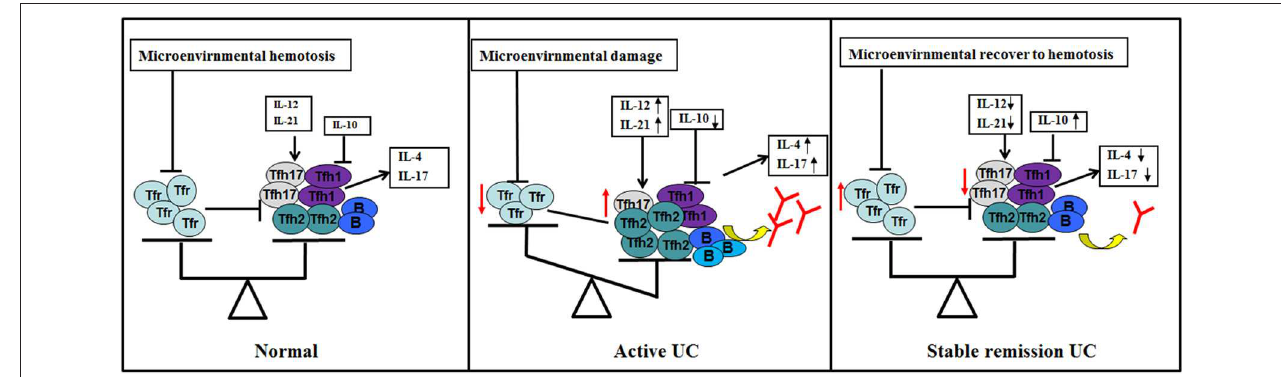
FIGURE 8 | Hypothetical schematic of the study. TFR and TFH and subgroups (TFH1/TFH2/TFH17) in normal human body (GALT and peripheral blood) are in equilibrium (left). When UC occurs and the disease is active (middle), (1) changes in microenvironment caused by certain factors, such as antigen or intestinal flora lead to a decrease in the number and/or function of TFR by some pathways; (2) changes in cytokines, such as IL12, IL-21, and IL-10 in the microenvironment also act on TFH to promotes elevated levels and subpopulation changes of TFH; (3) TFR and changes in cytokines act on TFH and act indirectly and/or directly on B cells; (4) B cells (memory B or plasma cells) have enhanced immune function, resulting in increased serum antibody levels and active clinical stage; (5) when the microenvironment of the body recovers, level and/or function of TFR and TFH are restored, TFR restores normal inhibition of excessive serum antibody production of B cell, helping UC patients progress from active to stable remission